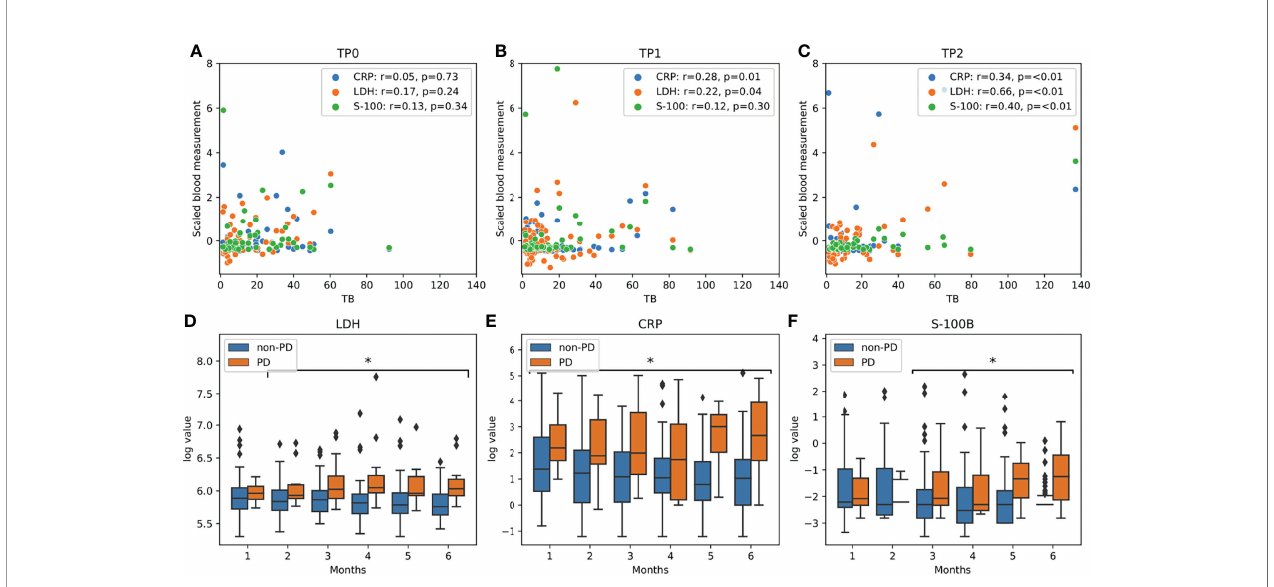
FIGURE 2 | Blood marker analysis: (A – C) scatter plots of tumor burden and blood markers for all three timepoints. Pearson ’ s r coef fi cients are given in the legend box. (D – F) Differences in LDH, CRP and S-100B levels during follow-up between progressive (PD: iPD and iUPD; n=15) and non-progressive patients (non-PD: iCR, iPR and iSD; n=79). Statistically signi fi cant different levels (p<0.05, using Mann-Whitney U test) for monthly follow-up are highlighted with an asterisk (*).